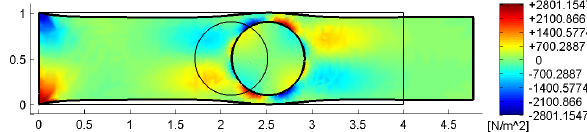
Figure 16: Shear stresses τ xy plotted on the deformed configuration (thin line: undeformed configuration; thick line: deformed configu- ration, amplification factor of the displacements: k = 500